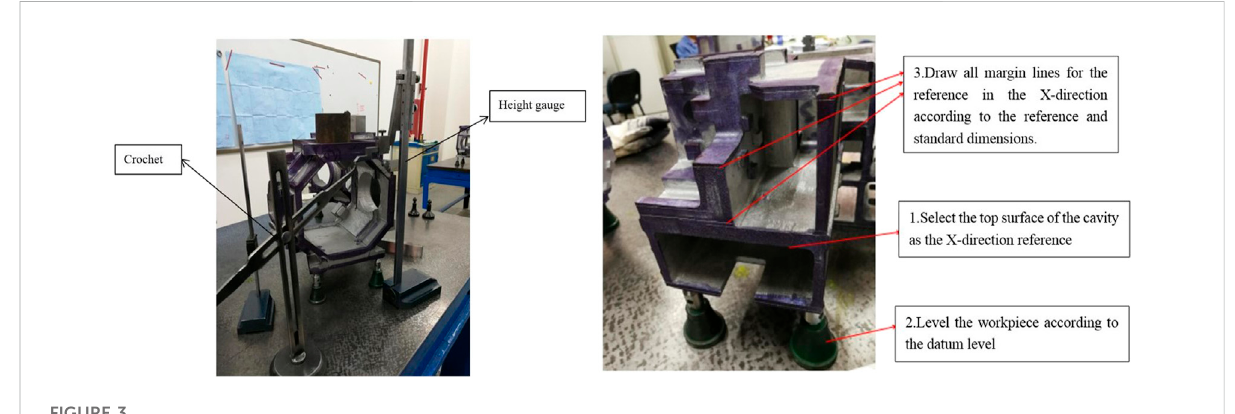
FIGURE 3 Tools and process of manual